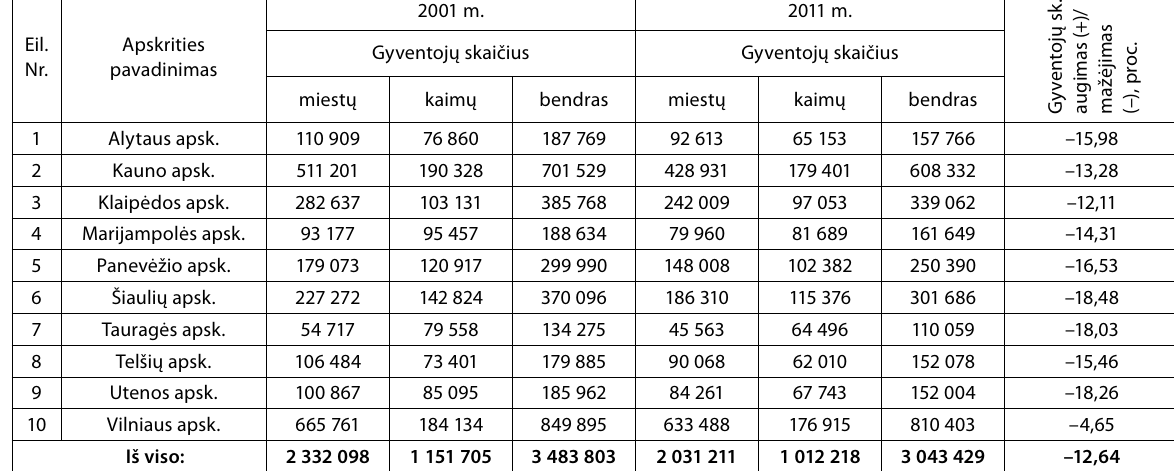
Table 2. The change of population in regions duering 2001–2011 (according analysis of lithuania statistics department results of Census of population and housing in 2001–2011 of the republic of lithuania)